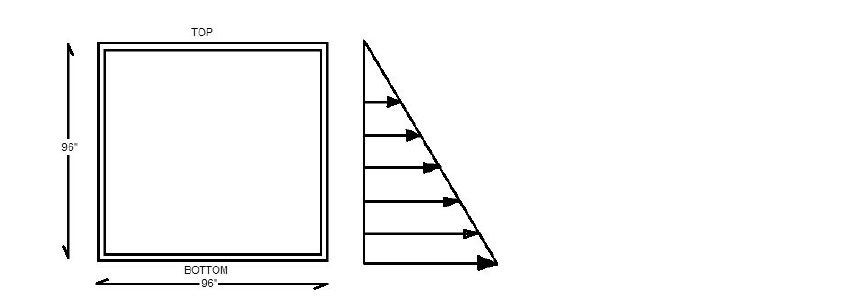
Figure 3. A two-dimensional beam-column system model with the external pressure load.